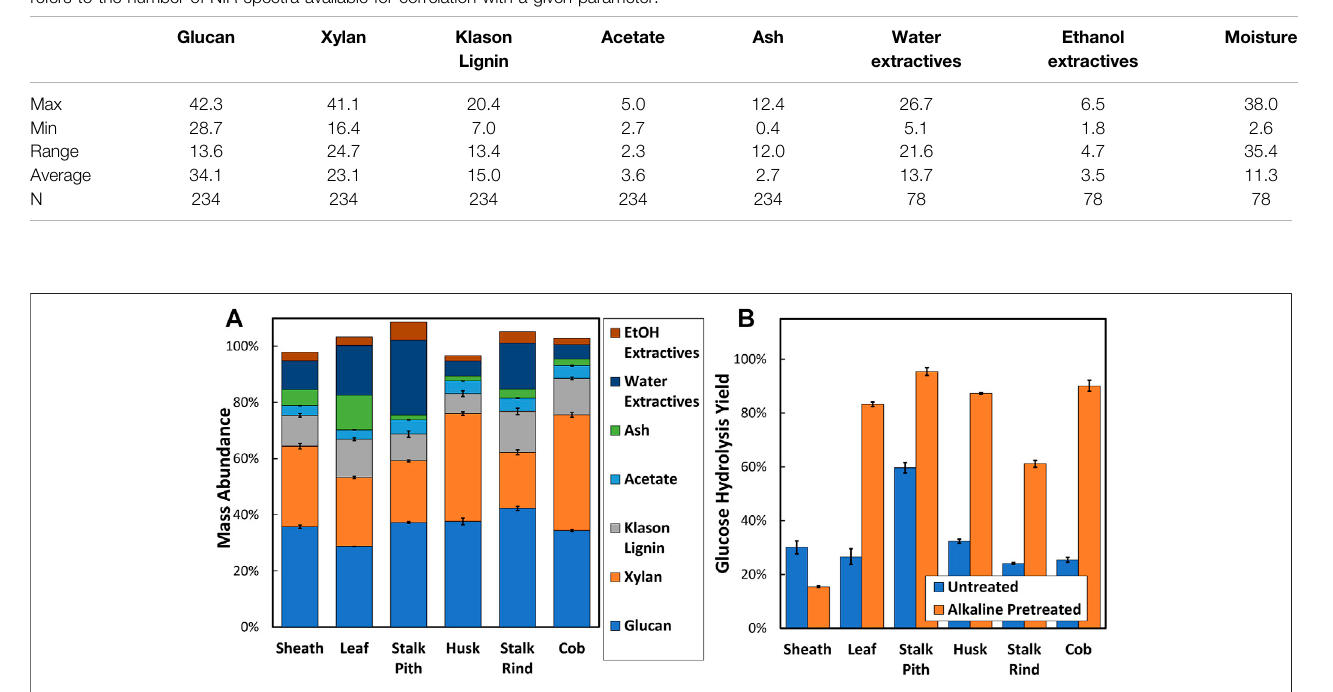
Frontiers in Energy Research |